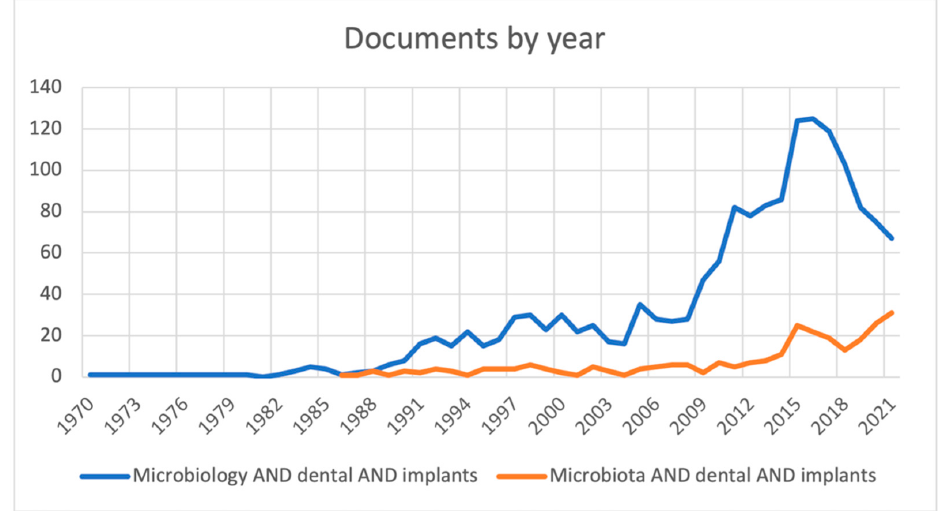
Figure 1. Number of research papers published until